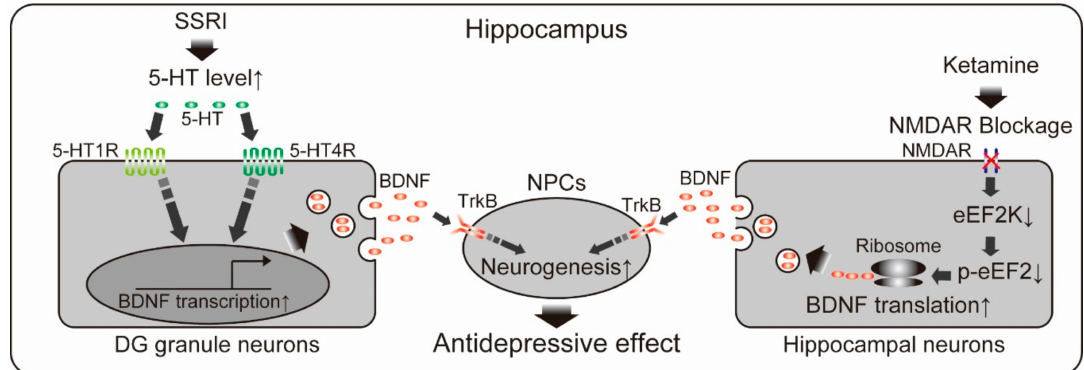
Figure 1. Schematic illustration of a possible molecular mechanism of selective serotonin reuptake inhibitor (SSRI)- or ketamine-induced antidepressive effect. NCPS: neural progenitor cells; DG: dentate gyrus. Both antidepressants increase BDNF production in hippocampal neurons via distinct pathways and finally increased neurogenesis by stimulating TrkB in NPCs. ↑ :Upregulation; ↓ :Downregulation; × at NMDAR means blockage of NMDAR; → at BDNF transcription means transcription of BDNF